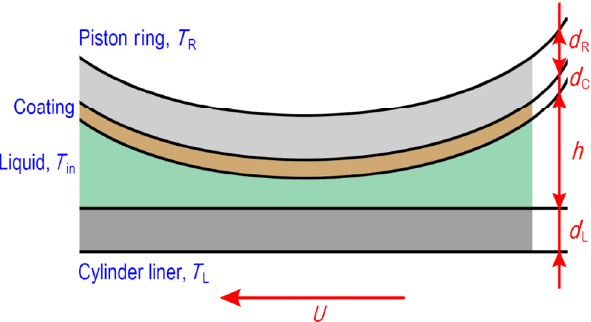
Fig. 2 Overview of the thermal analytical model for the coated and textured